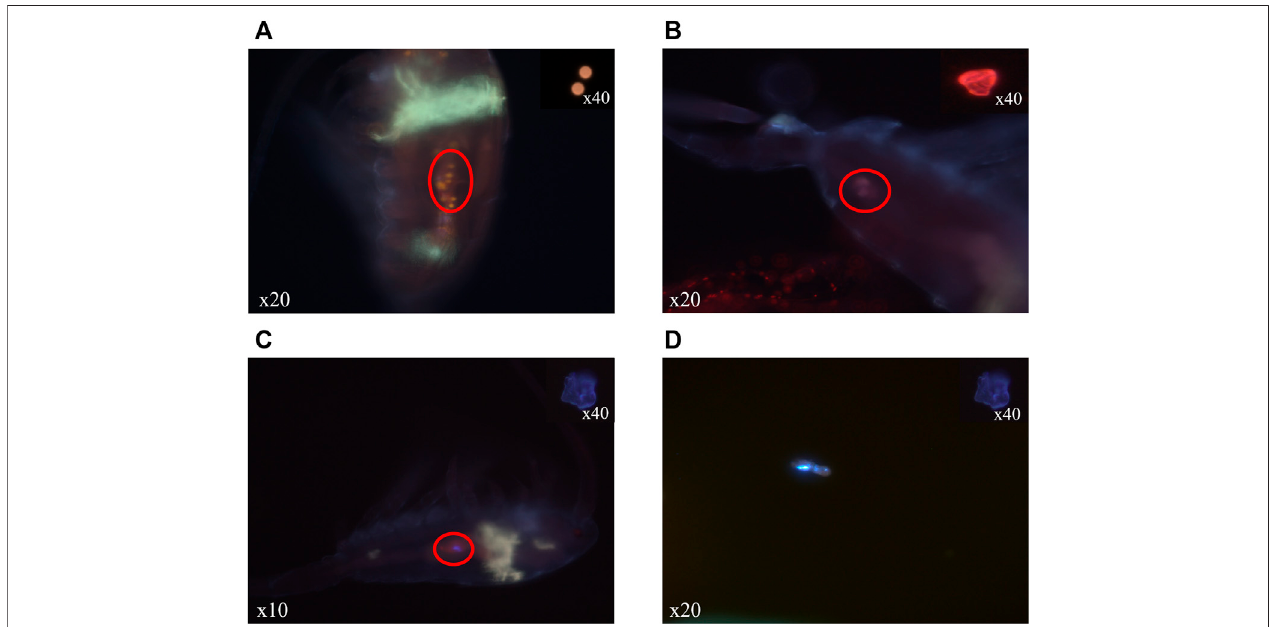
FIGURE1| MicroplasticsofPS (A) , PLA (B) and PE (C) , (D) stained withNile Red and detected (red circles) in digestive tracts (A – C) and faeces (D) after ingestion treatment of individuals of E. af fi nis with epi fl uorescence microscope (crime light: 455 – 494 nm).